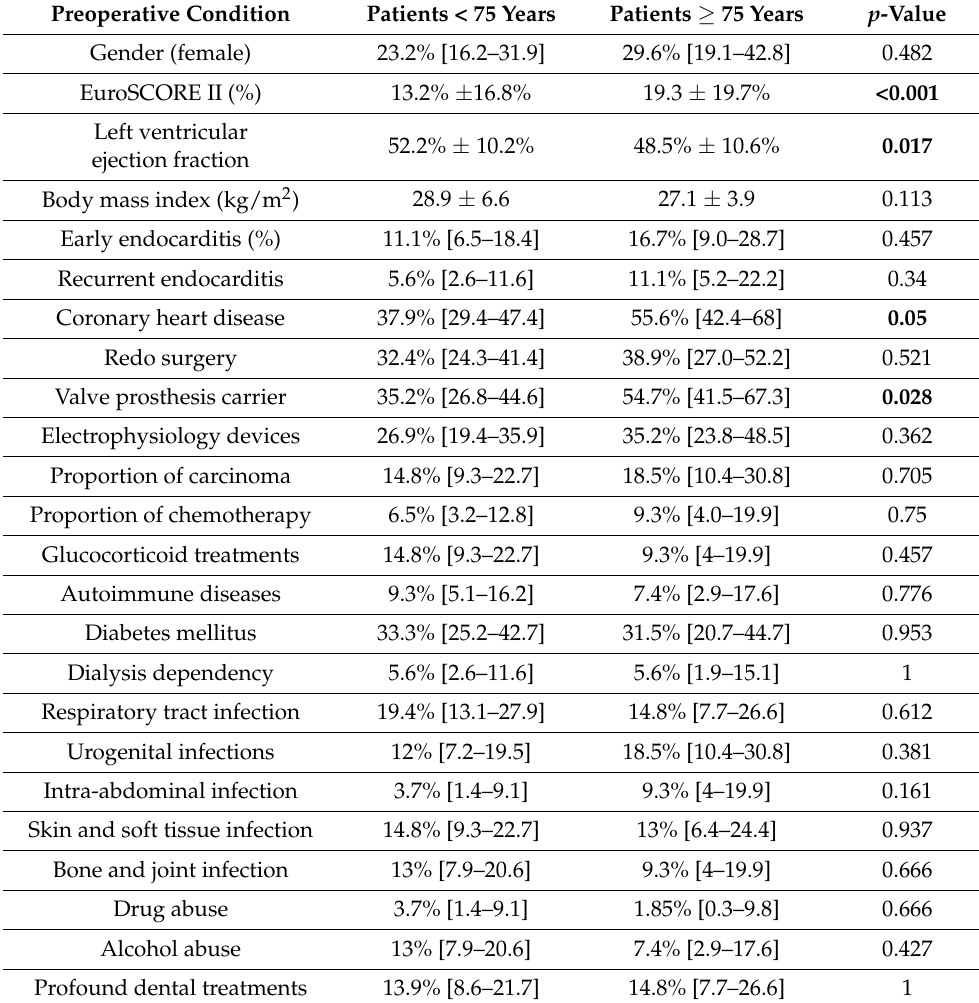
Table 1. Baseline, risk profile, and